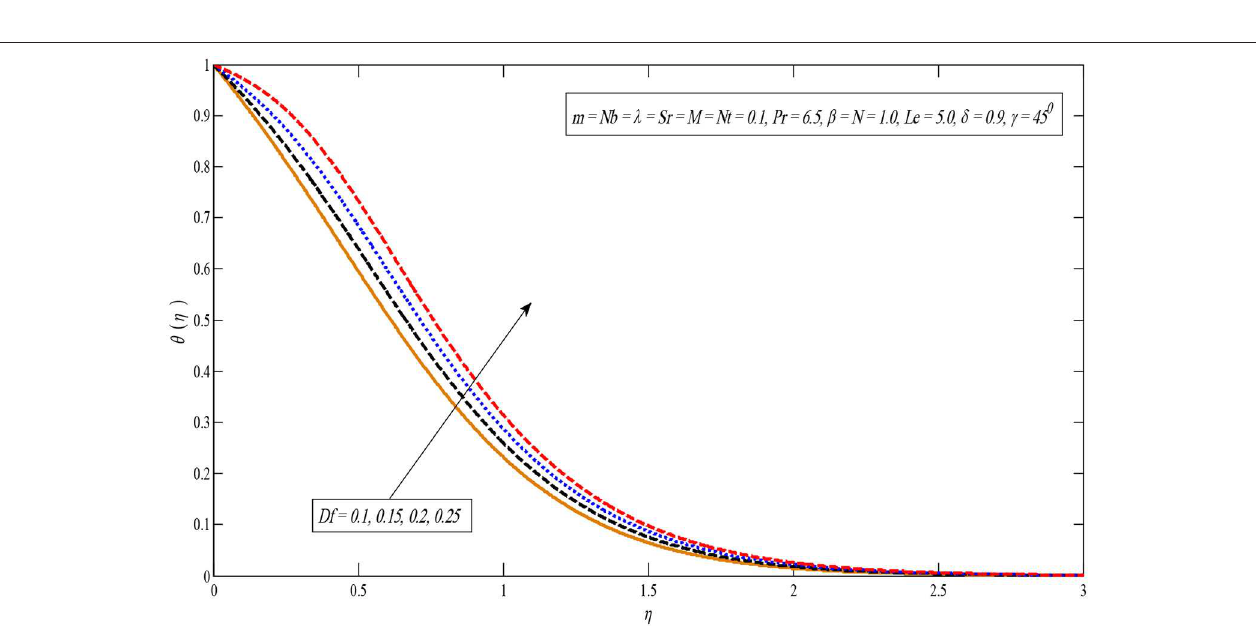
FIGURE 13 | Temperature profile for several values of Df